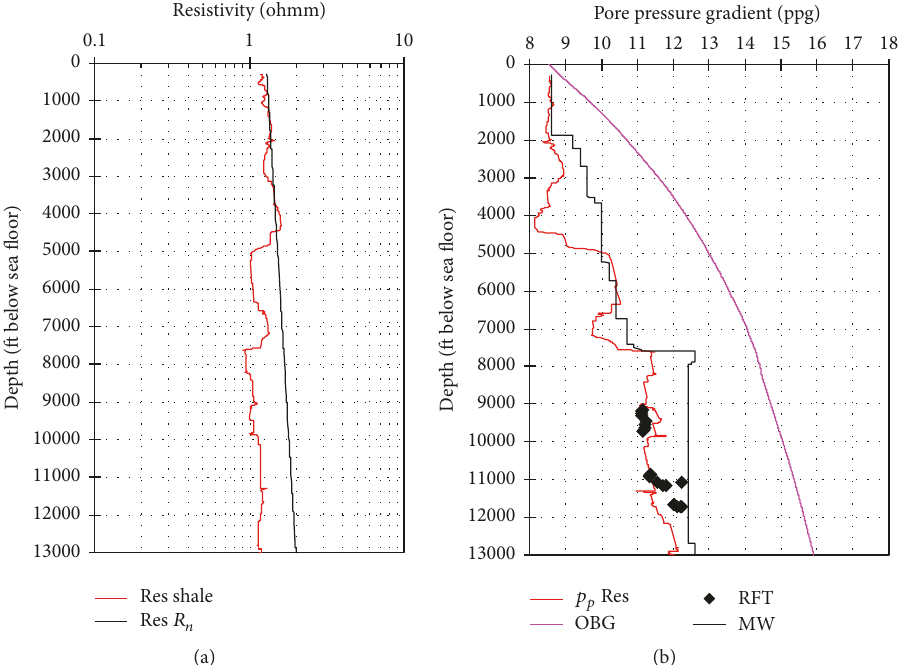
Figure 1: Measured and calculated pore pressure gradient and NCT calculated from the resistivity method ((1)-(2)).